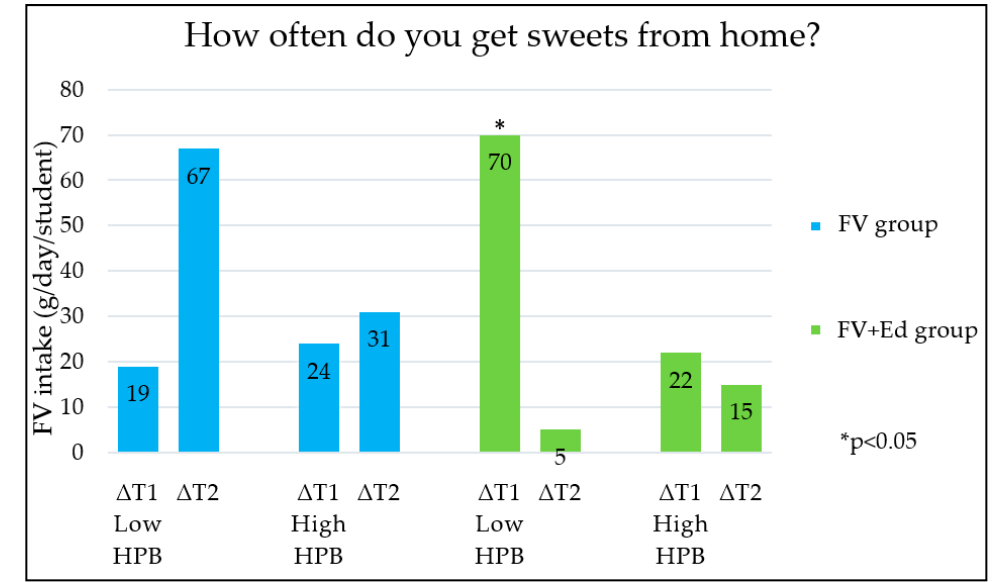
Figure 3. Differences in children’s FV intake, stratified by caregivers’ HPB in FV- and FV + Ed group, compared to the control group—Sweets provision. HPB = caregivers’ health promotion behaviour, ∆ T1 = Difference between T0 and T1, ∆ T2 = Difference between T0 and T2.